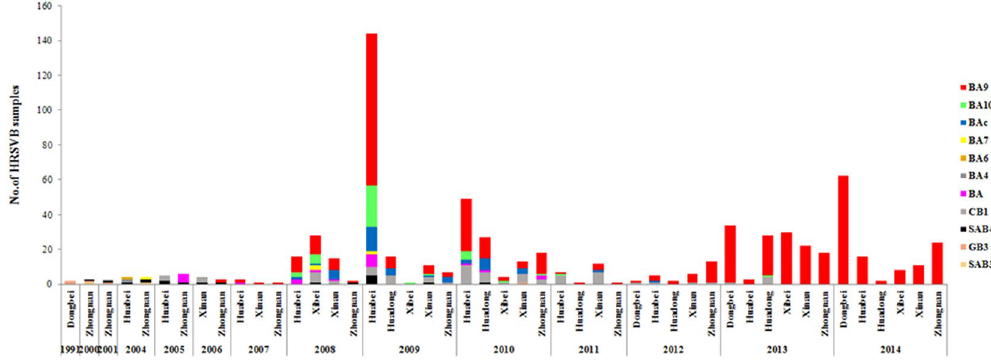
Figure 3. Yearly and geographic distribution of Chinese HRSVB genotypes from 1991 to